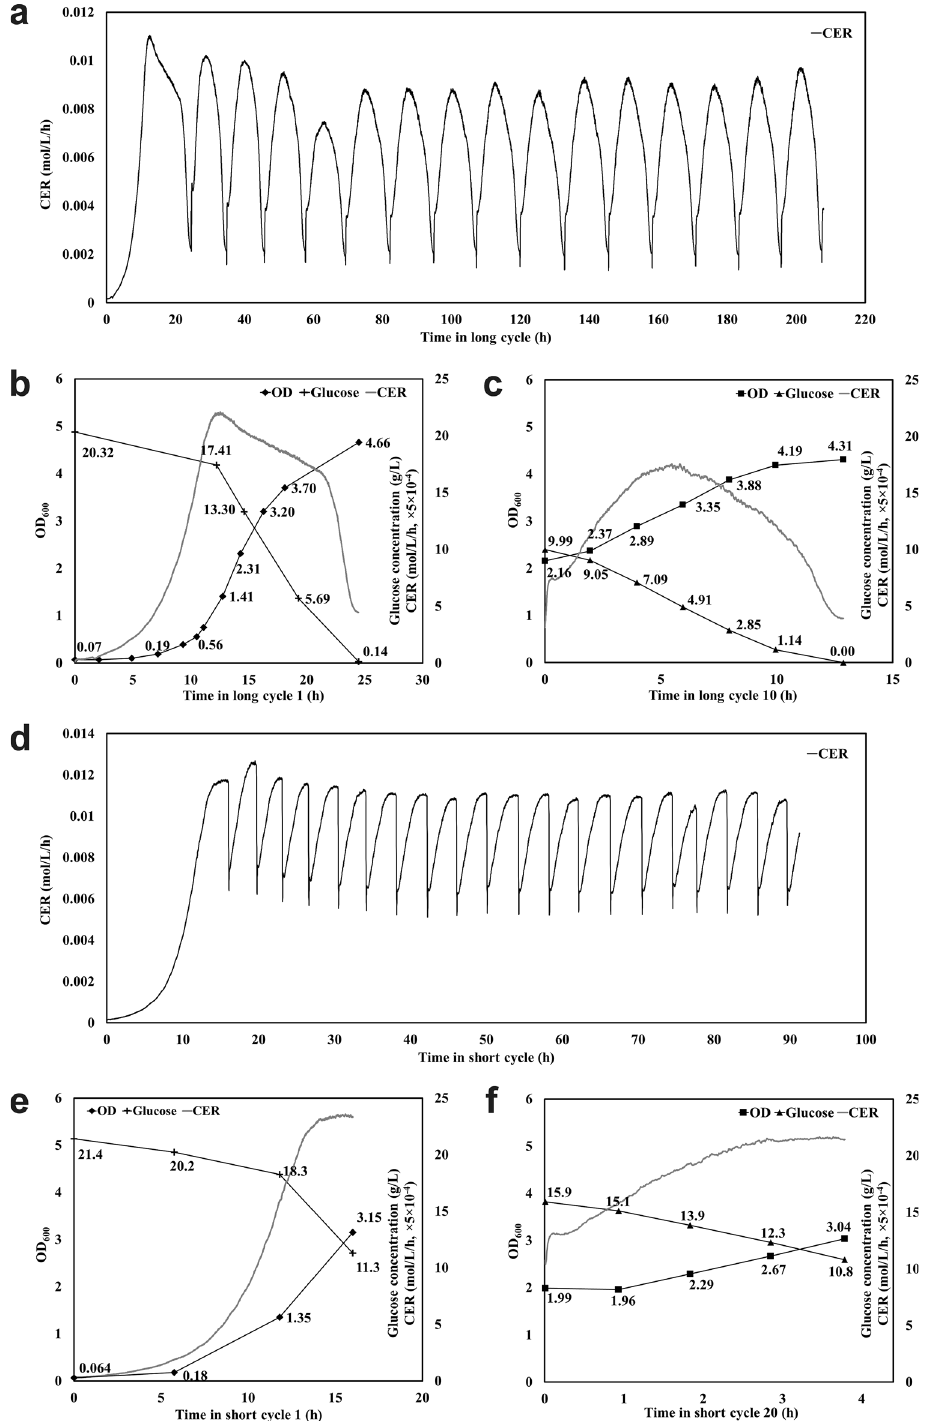
Figure 1. S. cerevisiae grown under SCF long- and short-cycle schemes. Long-cycle operation: ( a ) Carbon dioxide evolution rate (CER), ( b ) intracycle OD 600 , glucose concentration and CER in long cycle 1 (BR), ( c ) intracycle OD 600 , glucose concentration and CER in long cycle 10. Short-cycle operation: ( d ) CER, ( e ) intracycle OD 600, glucose concentration and CER in short cycle 1 (BR), ( f ) intracycle OD 600 , glucose concentration and CER in short cycle